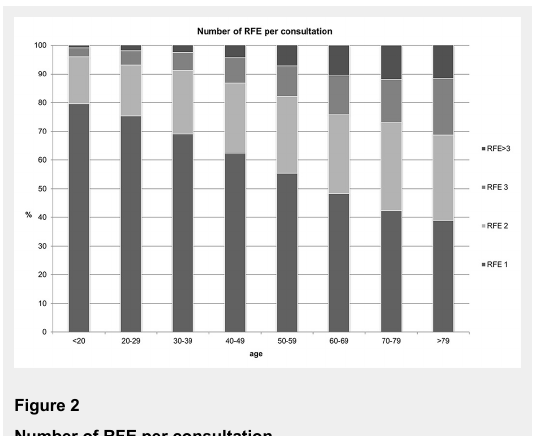
Number of RFE per consultation. Number of reasons for encounter (RFE), x-axis describes age of patients, y-axis describes percentages of each group.